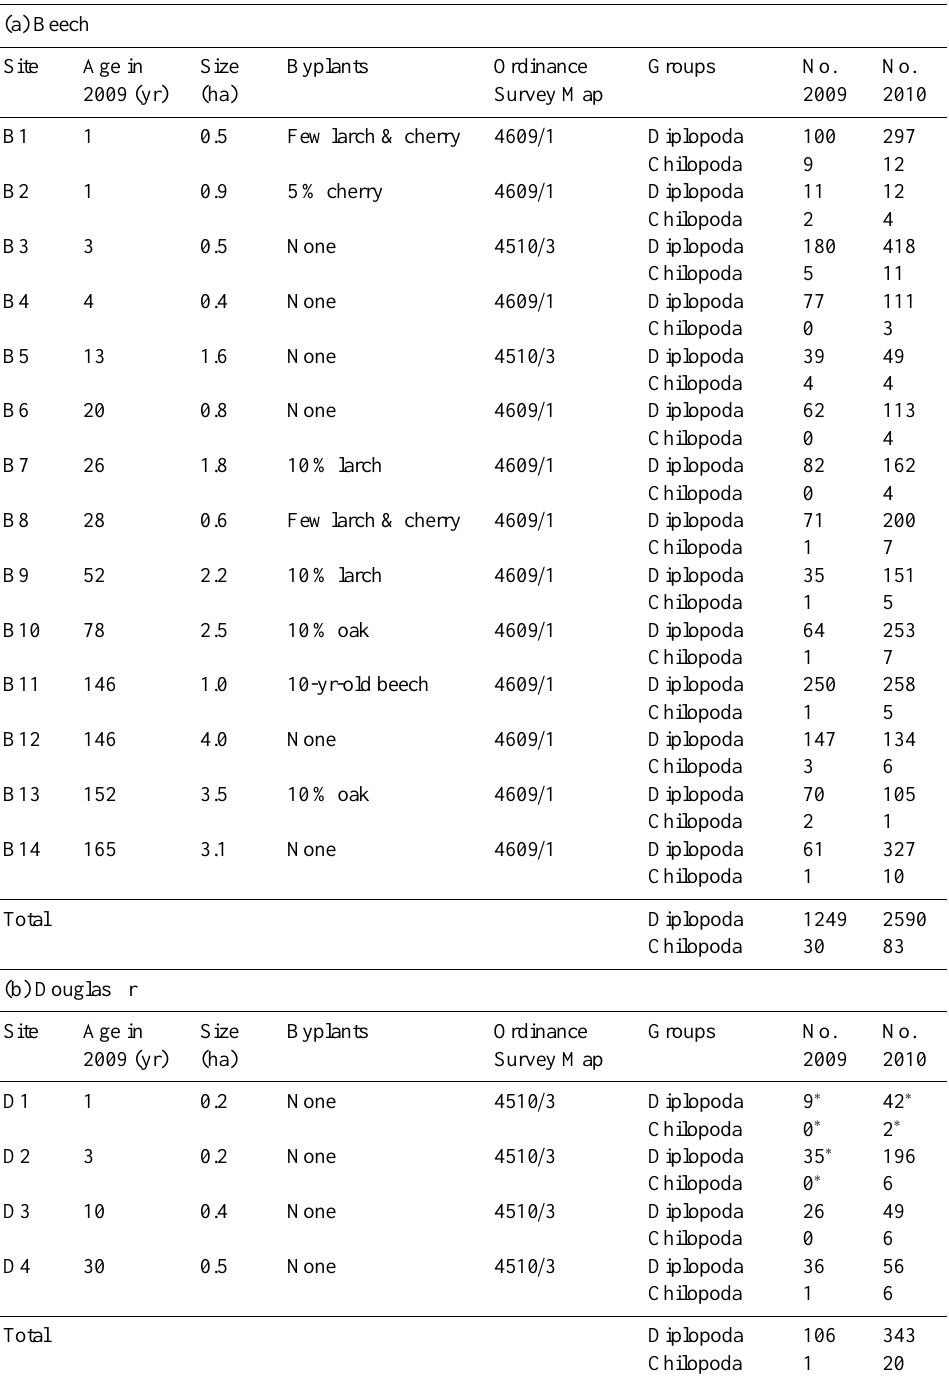
Table 1. Study sites and number of Myriapoda individuals over the vegetation periods 2009 and 2010: (a) beech, (b) Douglas fir, (c) spruce, and (d) fallow